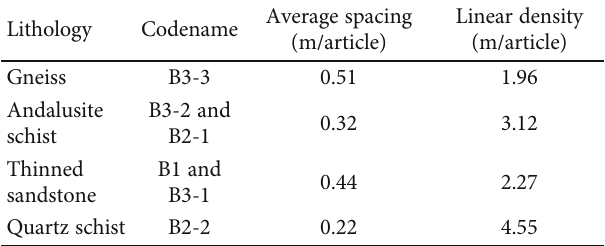
Table 4: Average spacing of the structural